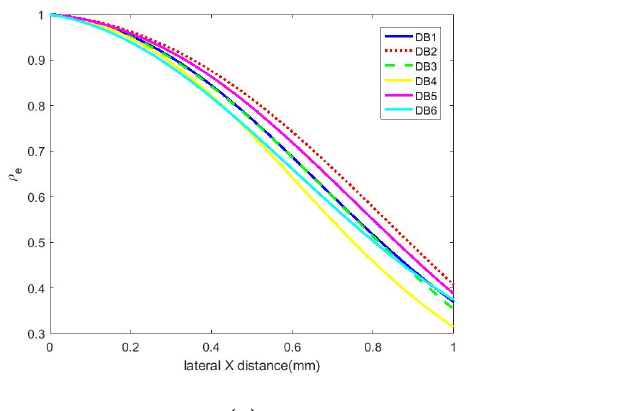
( a ) ( b ) Figure 20. Lateral displacement correlation coefficient of